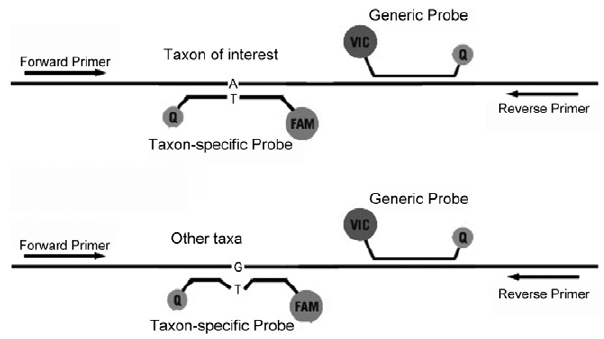
Figure 2. Taxon-specific qPCR for quantifying abundance of a specific taxon within the stomach microbiota. Two fluorescence probes (FAM and VIC) are located within the same PCR amplicon. The generic probe (VIC) targeting all bacteria sequences was used to quantify the total bacteria quantity. The taxon-specific probe (FAM) targeting to a specific taxon was used to quantify the quantity of the specific taxon. The taxon-specific probe matches perfectly to most species with the specific taxon, but has one or more mismatches to other species outside of the specific taxon. The ddCt value between VIC and FAM was used to quantify the abundance of the specific taxon.